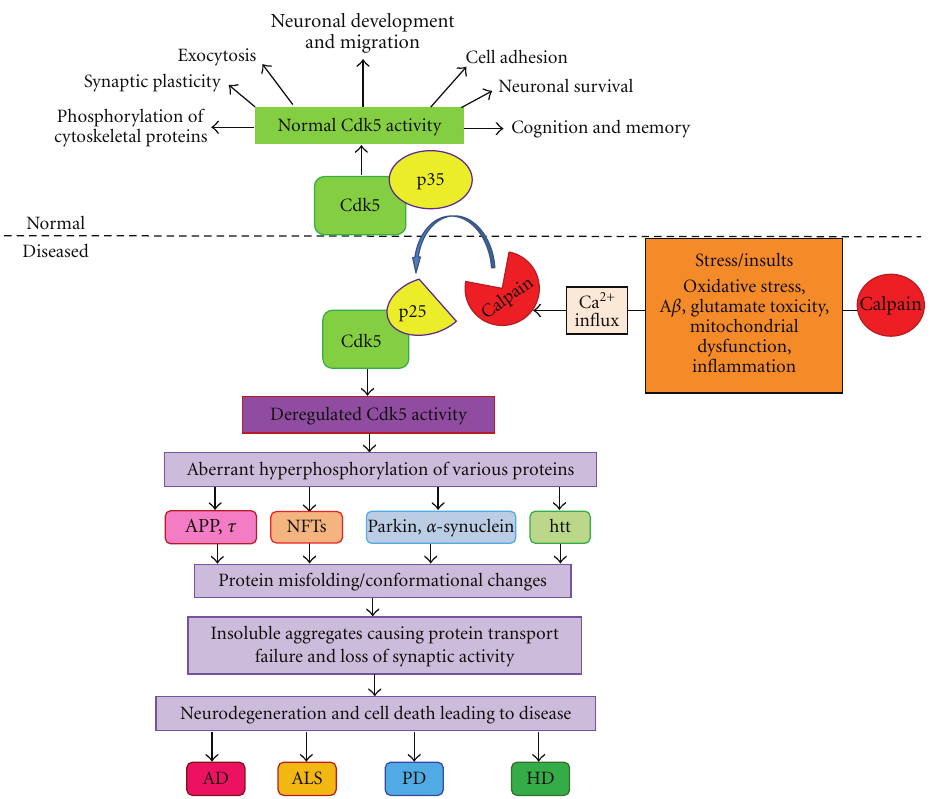
Figure 1: Summary of role of Cdk5 in physiology and pathology. Cdk5 is a proline-directed serine/threonine kinase and gets activated by its neuron specific promoter p35. Under normal physiological (normal) conditions, Cdk5/p35 is involved with various roles in neuronal development, cognition and memory, cell adhesion, phosphorylation of cytoskeletal proteins, and synaptic plasticity. When the neurons are stressed due to various insults like oxidative stress, inflammation, mitochondrial dysfunction, or toxicity due to A β or glutamate, there is an increase in Ca 2+ leading to activation of calpain, a protease. Calpain cleaves p35 to p25 deregulating Cdk5 activity as p25 forms a hyperactive and more stable complex with Cdk5. Cdk5/p25 activity causes aberrant phosphorylation of various proteins leading to conformational changes inducing gain of toxic function. Misfolded proteins lead to self-aggregation thereby overwhelming the system by blocking transport and disrupting synaptic activity. This ultimately leads to degeneration of neurons and finally be the cause of various neurodegenerative diseases like AD, ALS, PD, and